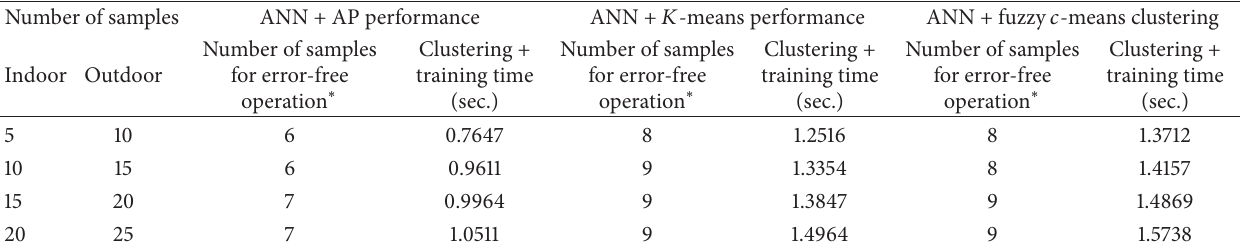
∗ The fraction values of the epochs are expressed by the nearest integer